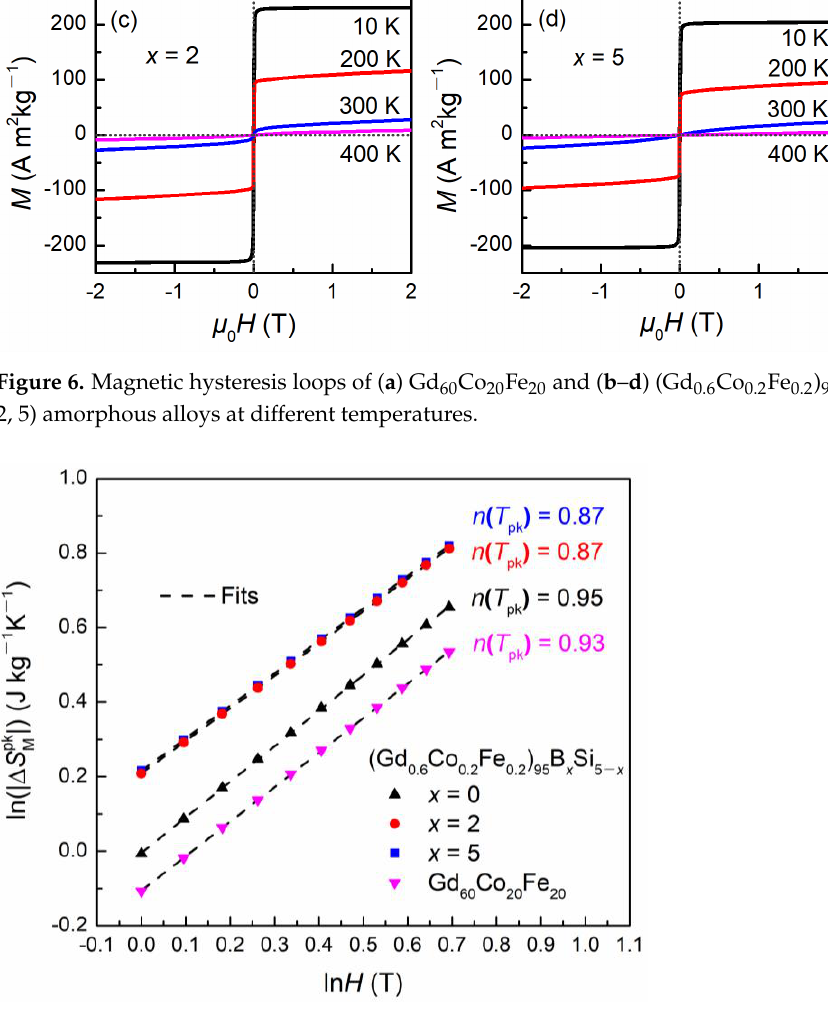
Figure 7. Ln–Ln plots of the field dependence of | ∆ S Mpk | with the calculated n ( T pk ) exponent for the Gd 60 Co 20 Fe 20 and (Gd 0.6 Co 0.2 Fe 0.2 ) 95 B x Si 5 − x amorphous ribbons.